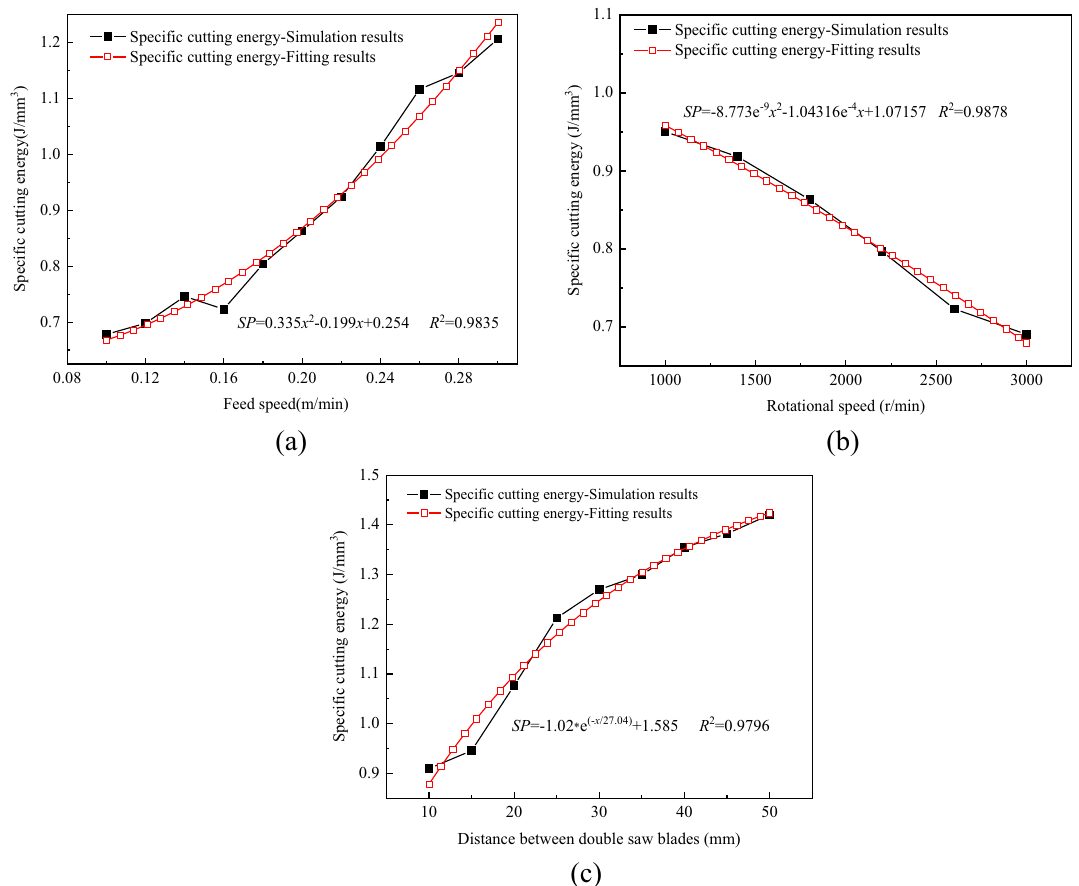
Figure 15. Specific cutting energy of circular saw blade with various cutting